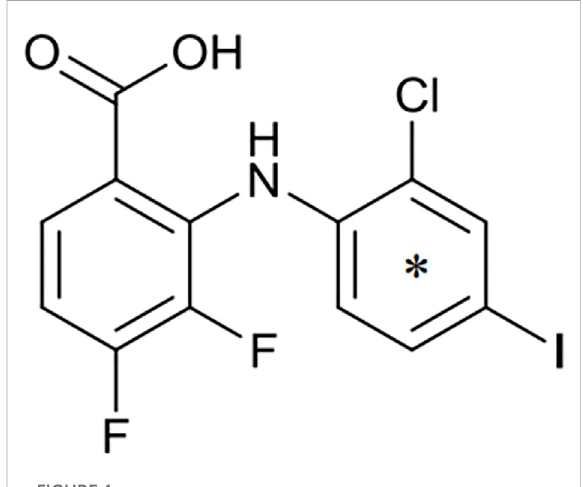
FIGURE 1 Structure of zapnometinib with position of 14 C-radiolabel. Position of radiolabel is indicated by the asterisk